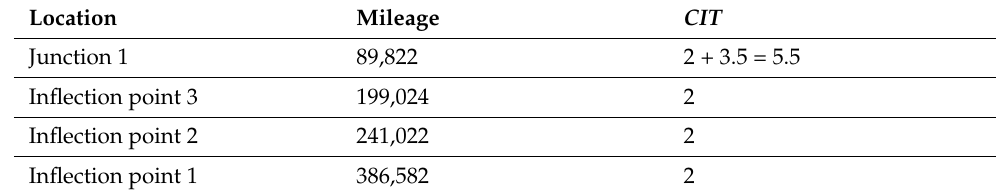
Table 2. The locations and weights of key points.